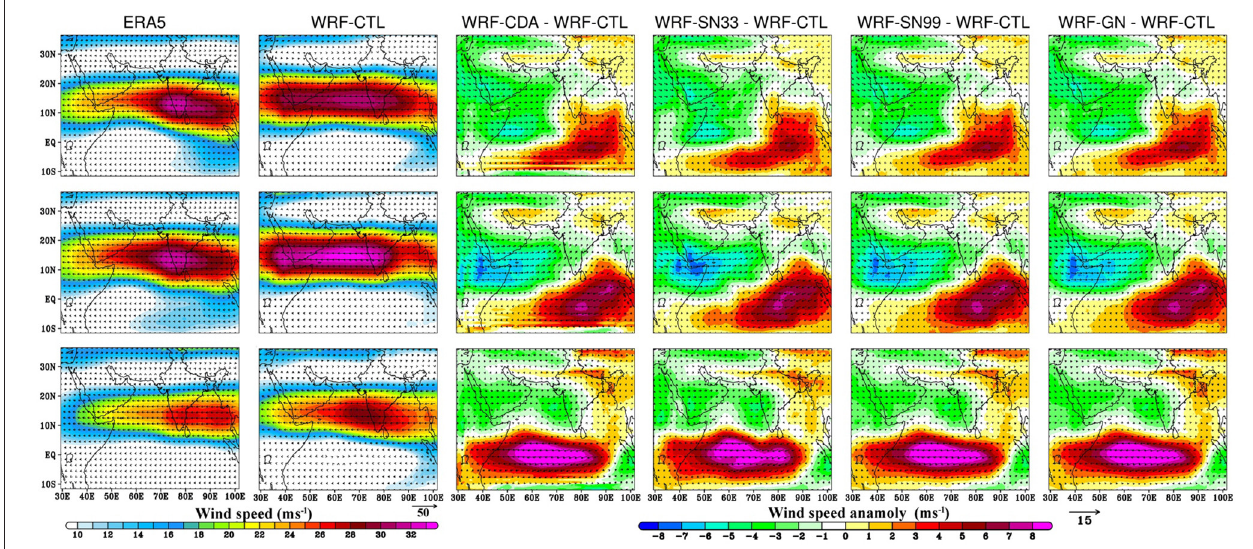
FIGURE 6 | The mean seasonal winds (m/s) at 100 hPa of ERA5 (First column) and WRF-CTL (Second column), and the differences in the mean zonal wind shear (m/s) between the WRF-CDA and WRF-CTL (Third column), WRF-SN33 and WRF-CTL (Fourth column), WRF-S99 and WRF-CTL (Fifth column), and WRF-GN and WRF-CTL (Sixth column) during normal (2016), excess (2013), and drought (2009) Indian Summer Monsoon seasons. First row is for normal, second row is for excess, and third row is for drought Indian Summer Monsoon seasons.